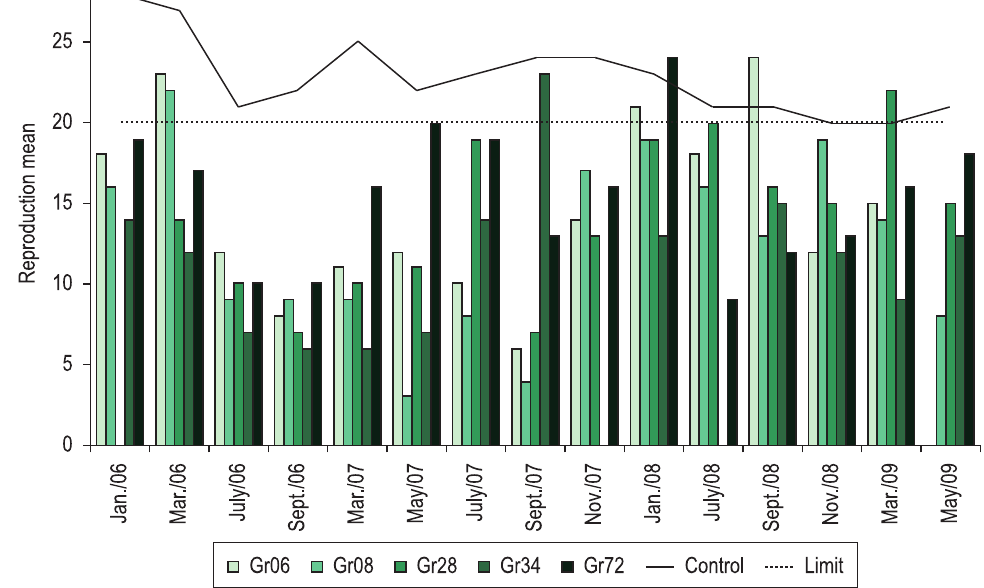
Figure 3. Mean reproduction of Daphnia magna exposed to Gravataí River sediment samples, control group and expected mean, from January/2006 to